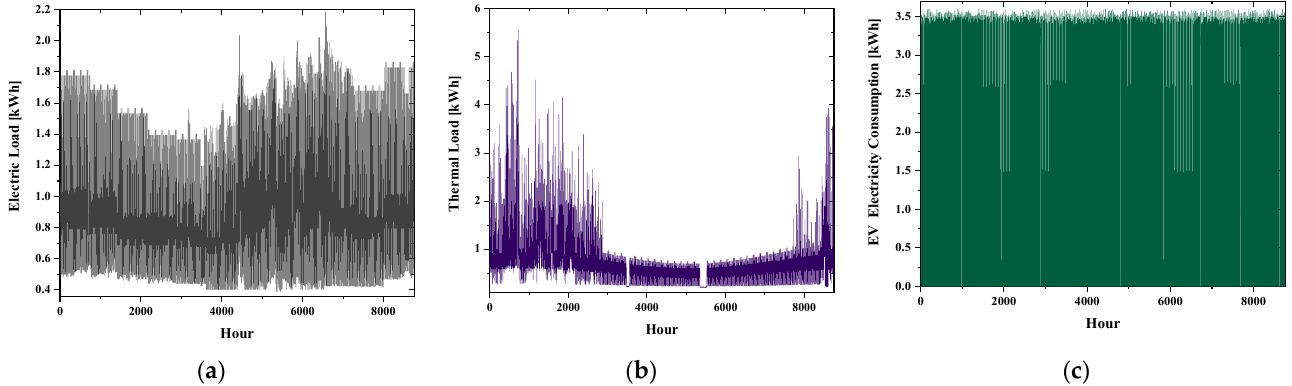
Figure 5. Meteorological data for the understudy location: ( a ) solar irradiance; ( b ) ambient temperature.